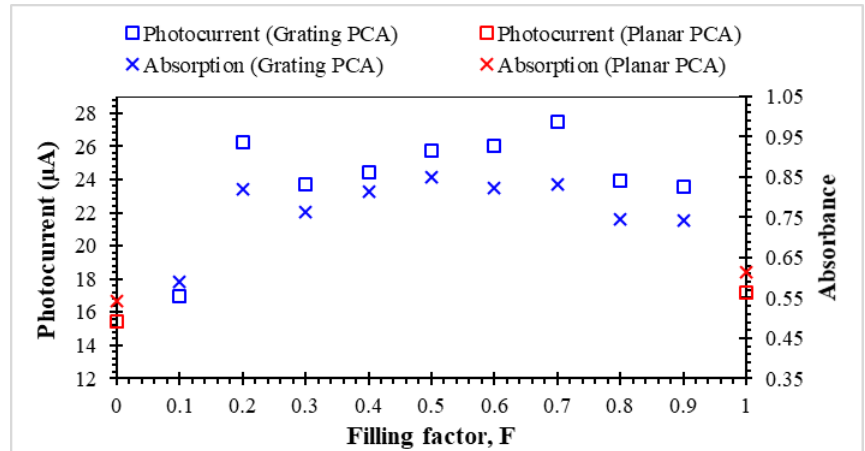
Figure 9. The photocurrent in the grating PCA (blue square) and the planar PCA (red square) with various F and their corresponding optical absorbance (blue cross for grating PCA and red cross for planar PCA). Note that the case of F = 0 corresponds to the planar PCA with a thickness of H , while F = 1 refers to the planar PCA with a total thickness of H + D .